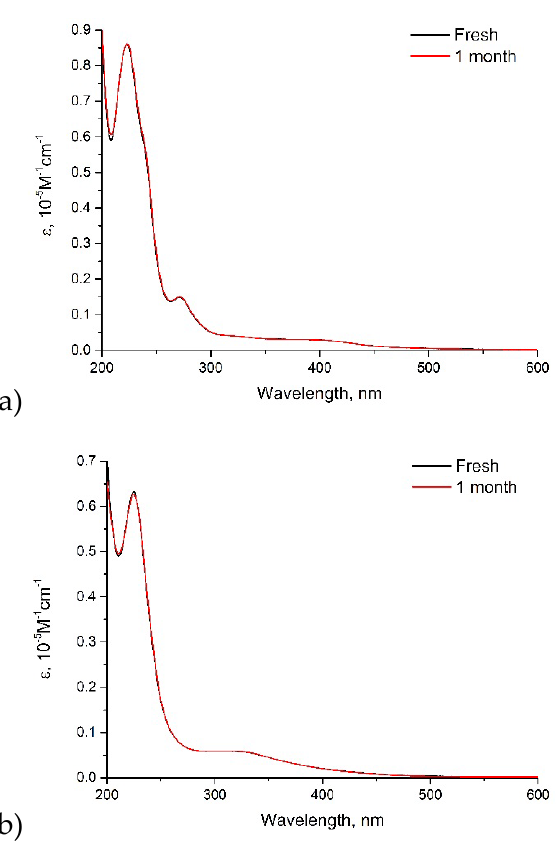
Figure 3. UV-Vis spectra of compounds 4 ( a ) and 5 ( b ) recorded for the freshly prepared aqueous solutions and for the solutions aged for 1 month.